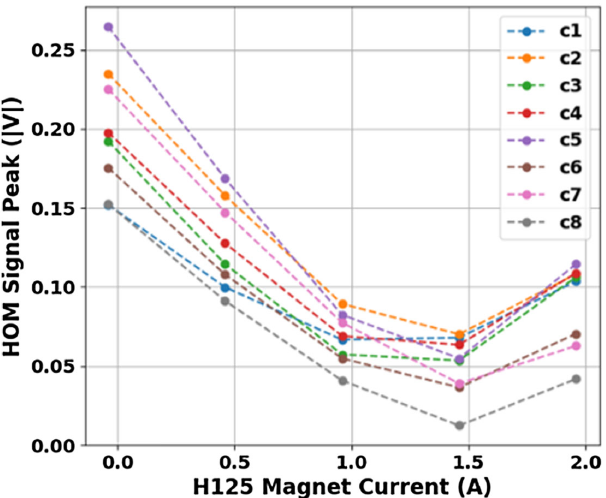
FIG. 6. Initial plots of the CM2 HOM US peak signals vs H125 corrector current values. One amplifier is used in each channel with a charge at 125 pC = b and 50 b. A 300-shot average was